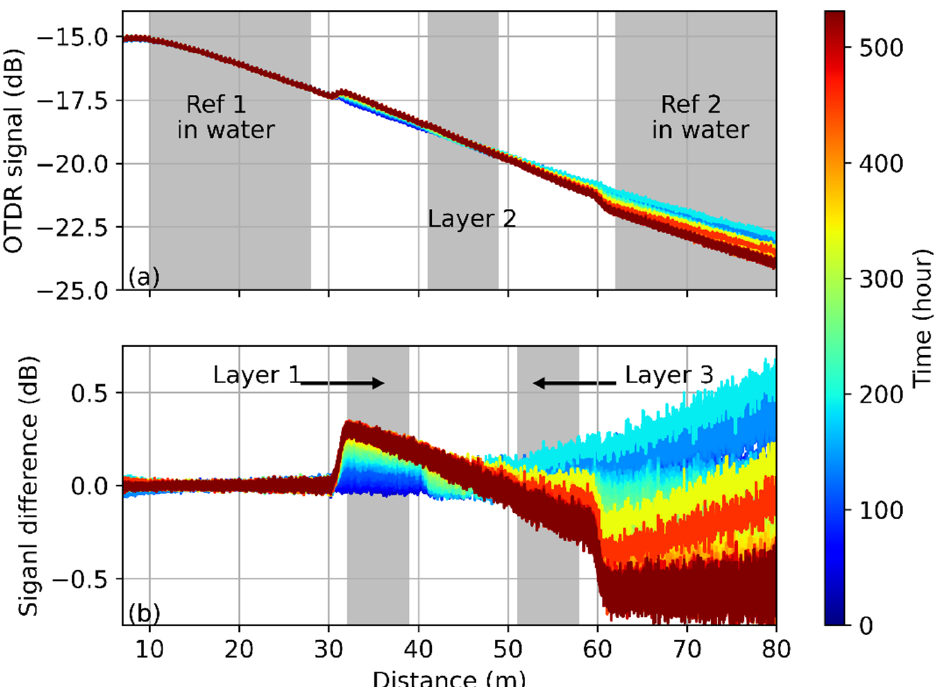
Figure 4. OTDR measurement at 500 nm during the concrete drying. ( a ) Obtained OTDR traces and ( b ) OTDR signal changes compared with the first trace. Trace color denotes the measured time.